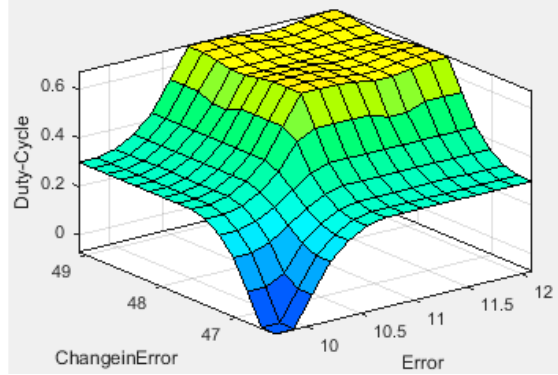
Figure 12. Surface Viewer of